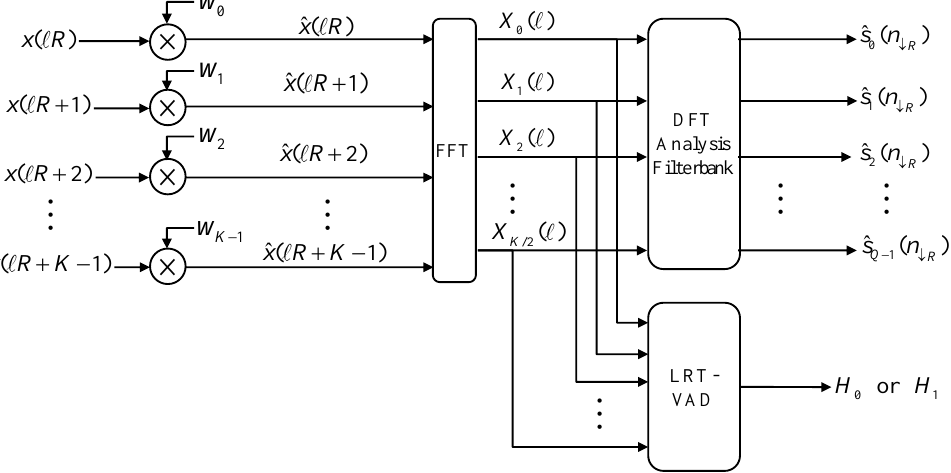
Figure 1. Block diagram of the voice activity detection (VAD) implemented on the auditory device filter bank.